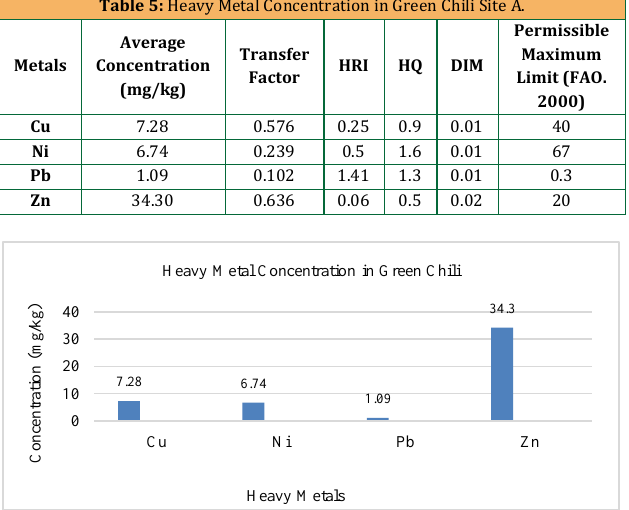
Table 5: Heavy Metal Concentration in Green Chili Site A.